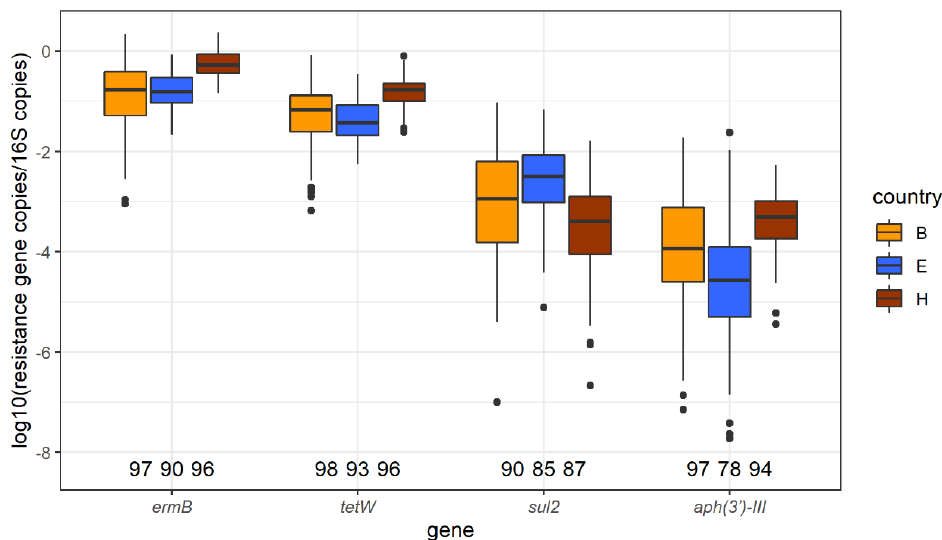
Figure 3. Relative abundance of ermB , tetW , sul2 , and aph3′-III in turkey faeces sampled in three countries, detected by qPCR. Resistance gene log 10 copies were normalized using 16S rRNA abun- dances. The numbers displayed above the horizontal axis are the number of the samples eligible for analysis.